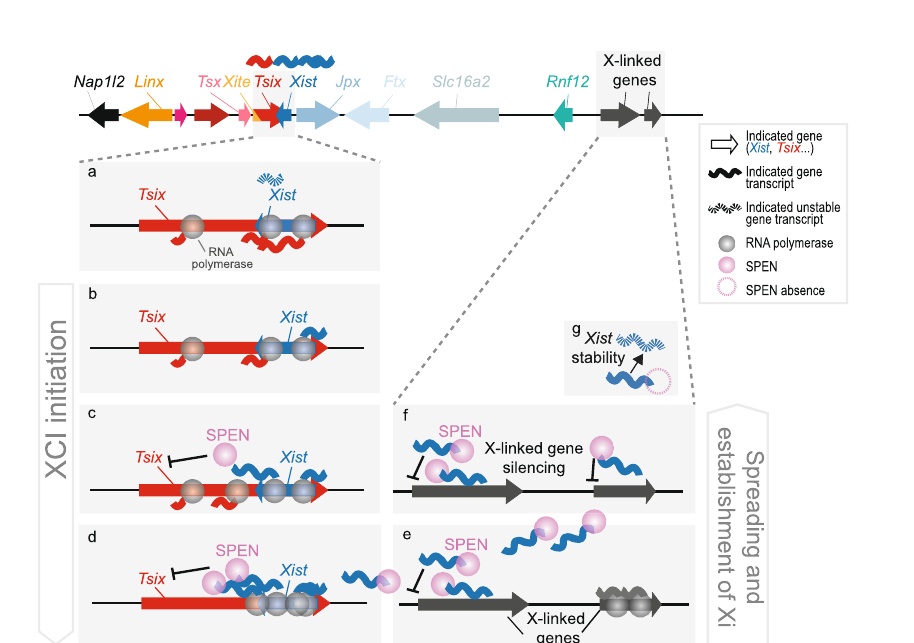
Fig. 7 Model of the role of SPEN in XCI. In the undifferentiated state, Tsix transcription represses Xist and Tsix RNA levels are high ( a ). Upon differentiation, at the start of XCI ( b – d ), Xist transcription increases ( b ), the nascent Xist transcripts recruit SPEN that is necessary to silence the Tsix promoter through removal of active H3K27ac marks ( c ). Consequently, the silencing of Tsix allows Xist upregulation and accumulation ( d ). Later, during the establishment phase of XCI, the spreading of SPEN- Xist along the X chromosome allows the silencing of active genes ( e , f ). Moreover, SPEN is also necessary to stabilize Xist RNA ( g ). This model, in addition to previous evidence, proposes that SPEN is not only key in X-linked gene silencing, but also in initiation of